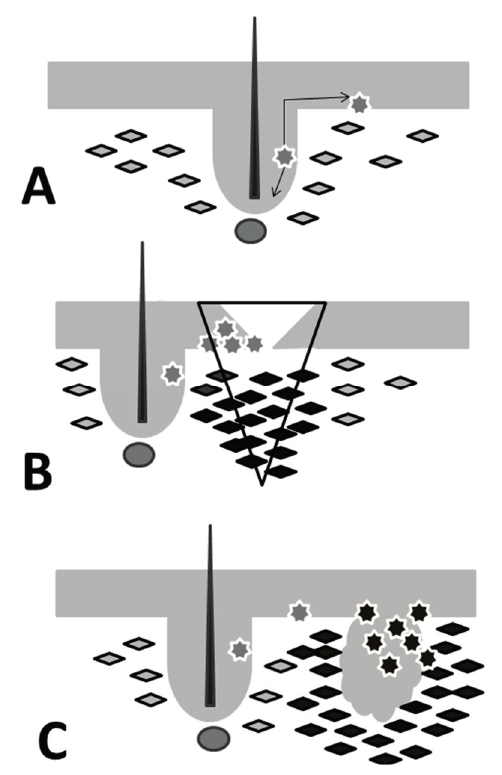
Figure 1. Comparison of wound healing and cancer. Multipotent epidermal stem cells are present in bulge region of hair follicle and interfollicular progenitor cells (grey asterisks) are present in basal layer of epithelium. Dermal fibroblasts (quadrangles) are separated from the epithelium by basement membrane form the functional unit with epithelial